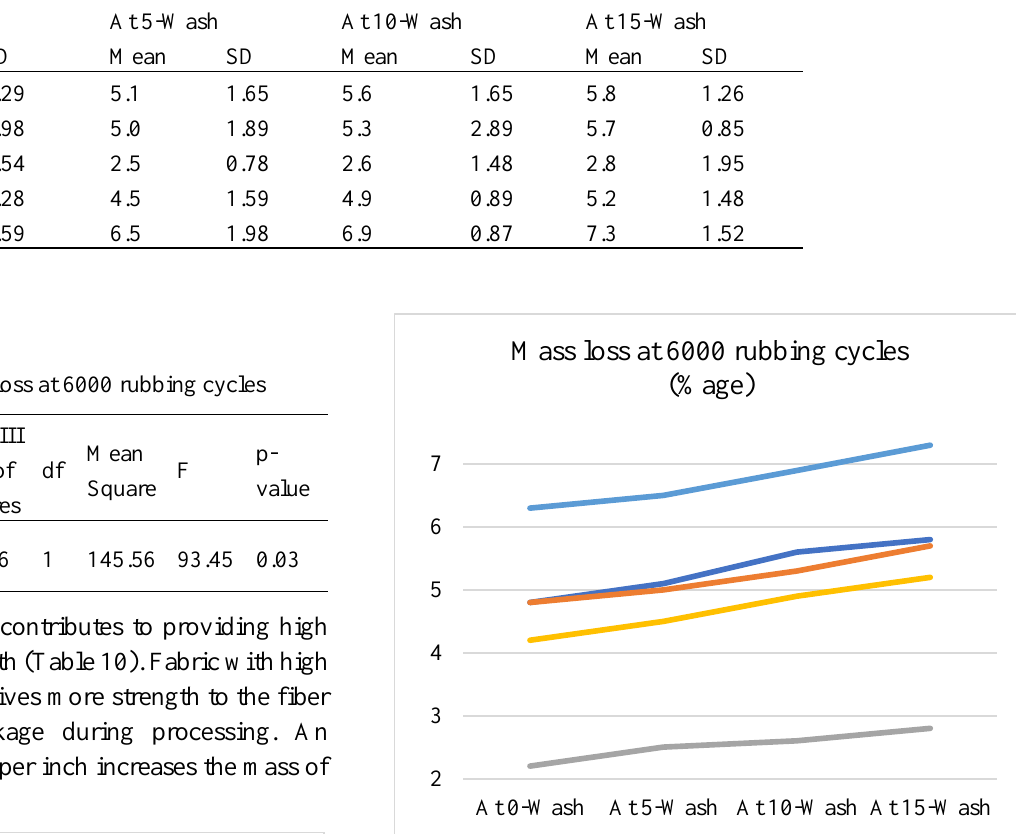
Mass loss at 6000 rubbing cycles at washing intervals Sample